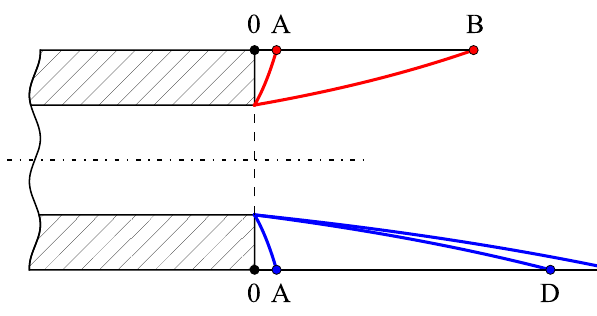
Figure 3. Displacement history of the points of the cylinder